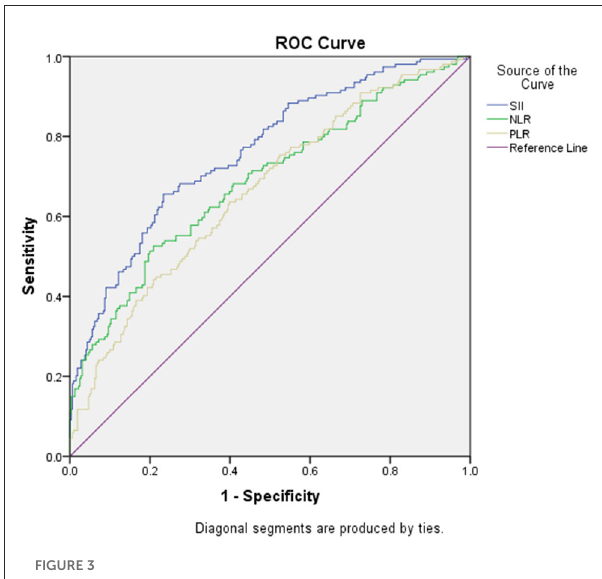
FIGURE3 Receiver operating characteristic curve.